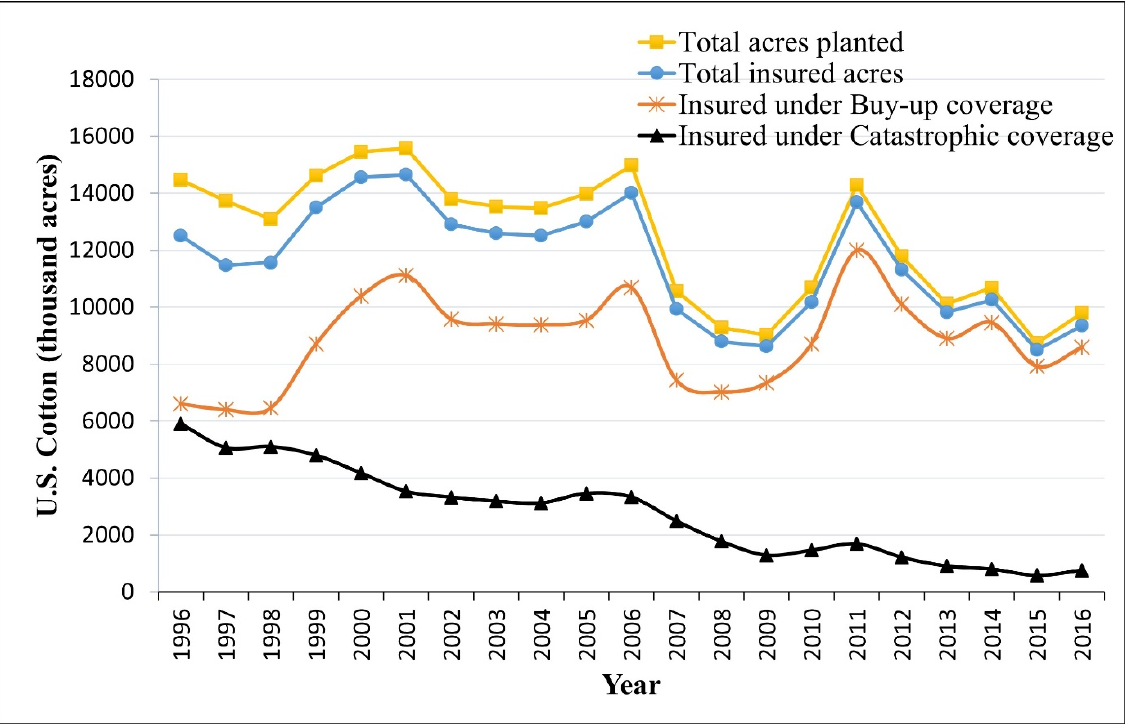
Figure 2. Insured US upland cotton acreage by coverage types, 1996–2016.